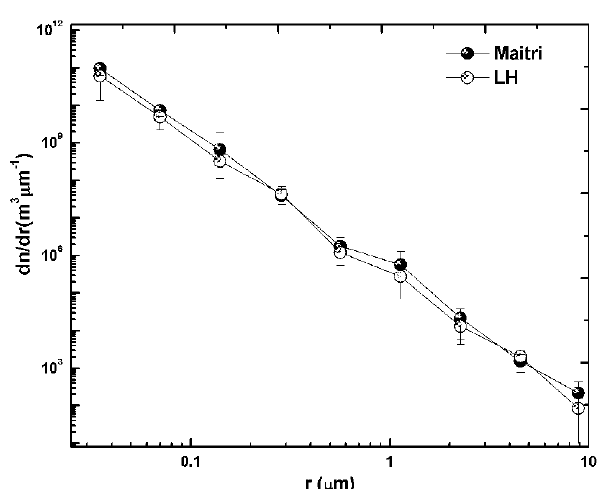
Fig. 8. Aerosol number size distributions for Maitri and LH esti- mated from QCM measurement. The solid circles are for Maitri where as open circles are for the Larsemann Hills